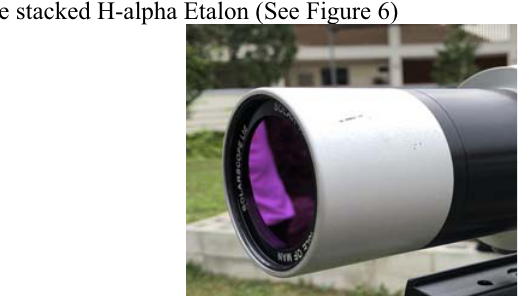
Figure 5. Calcium-K Filter